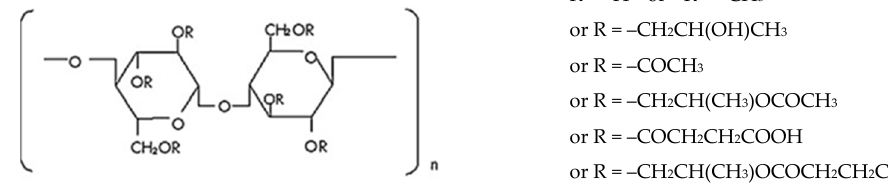
Figure 7. Chemical structure of hydroxypropylmethylcellulose acetate succinate [34,35].